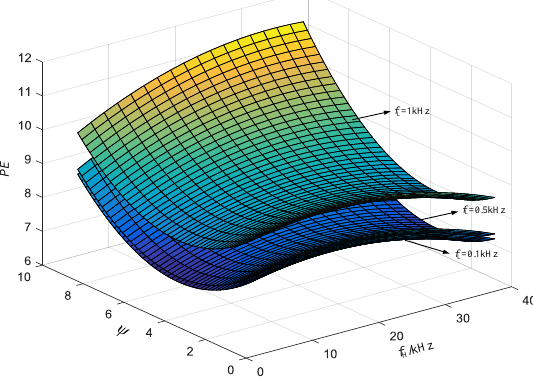
Figure 7. Response surface on percent elongation ( PE ).